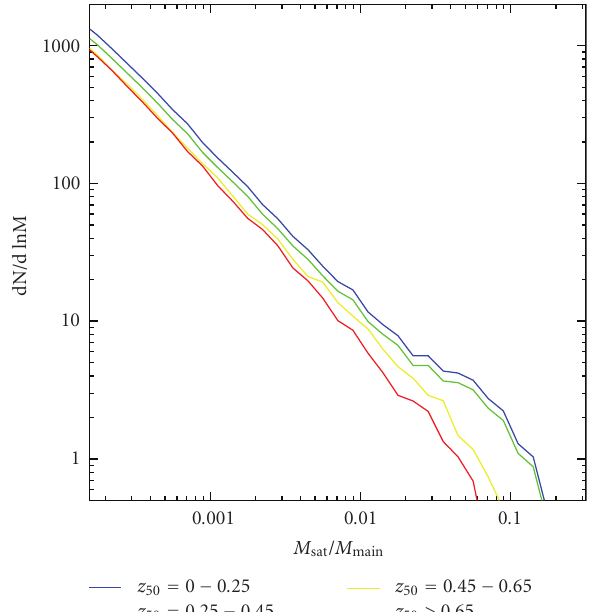
Figure 3: The evolution of a single cluster halo versus time. The bottom panel shows how the total mass (upper black line) and the mass within the central 390 kpc (lower red line) build up with time. The upper panel shows how the number of satellites changes with time. The dashed curves are for satellites with masses in excess of 10 11 M (cid:2) , 10 12 M (cid:2) , and 10 13 M (cid:2) , respectively, from top to bottom. The solid curves are for satellites with masses of more than 0.1% or 1% of the main system’s mass, respectively, from top to bottom.